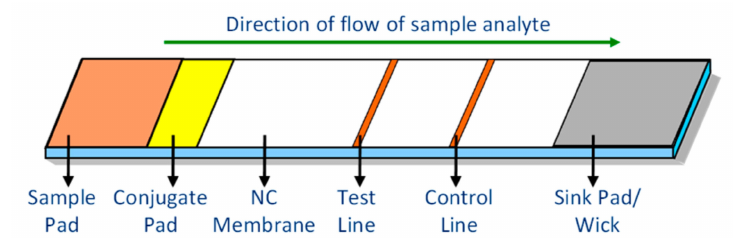
Figure 1. Typical configuration of a lateral flow immunoassay test